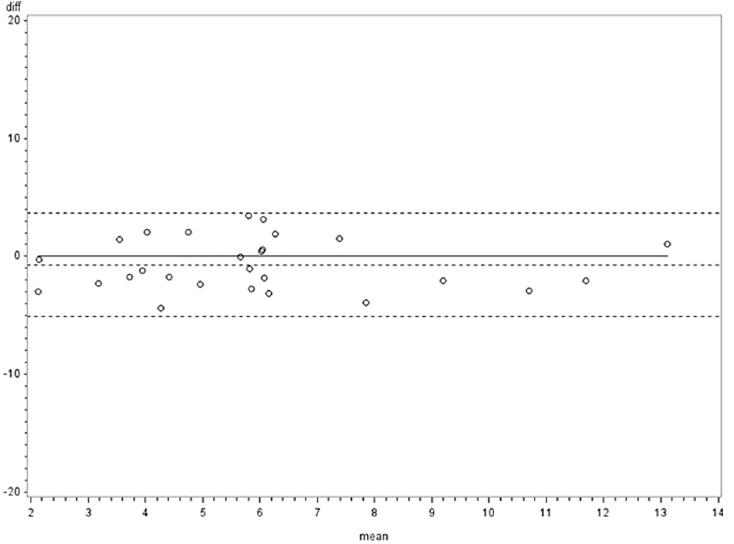
Fig 3. Mean differences in the PDFF values for two radiologists plotted across 95%